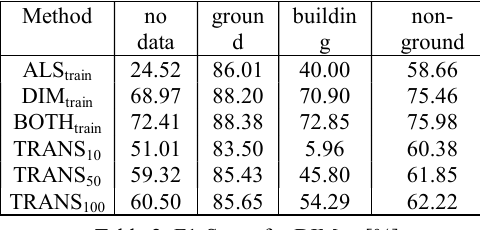
Table 2. F1-Score for DIM test [%]